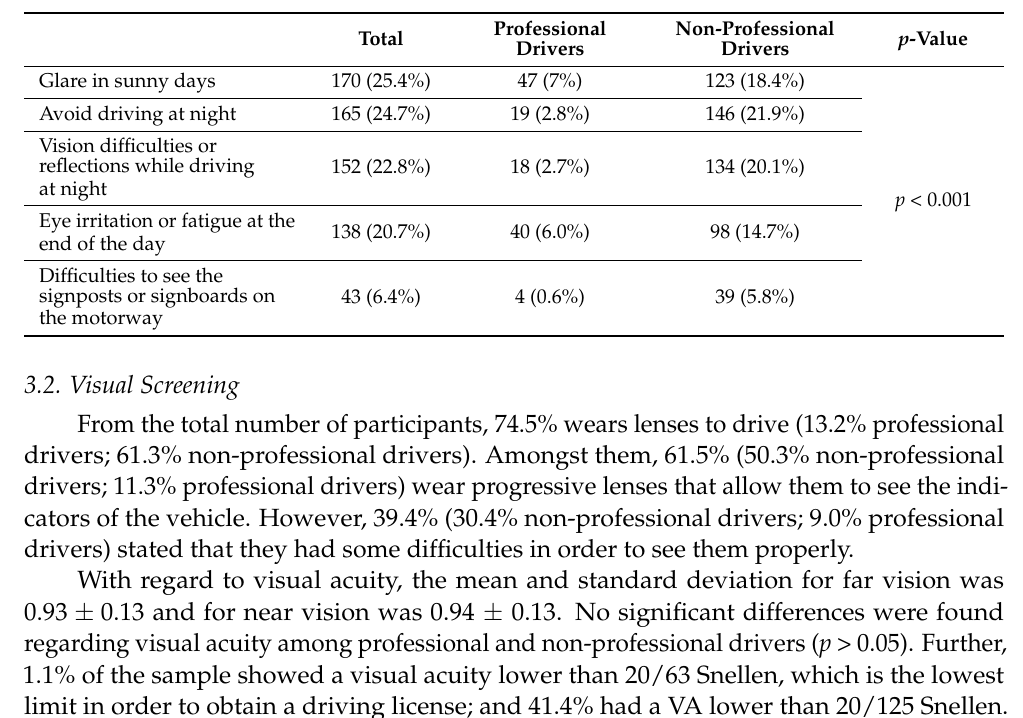
Table 2. Symptomatology while driving.